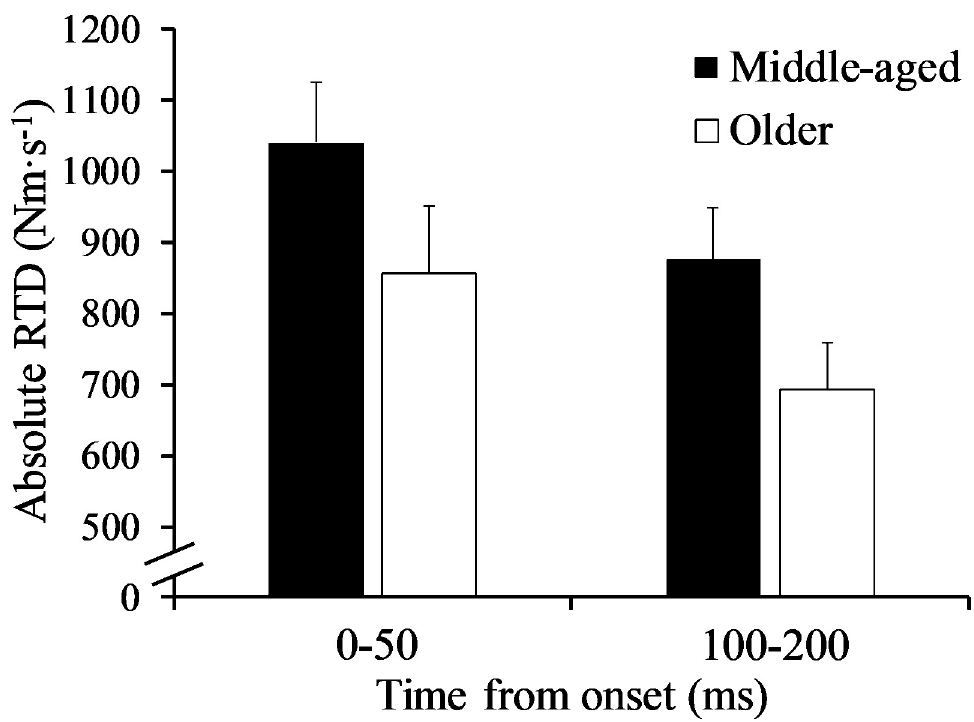
Fig 2. Early (0–50 ms) and late (100–200 ms) absolute rate of torque development (RTD) in the middle-aged and older